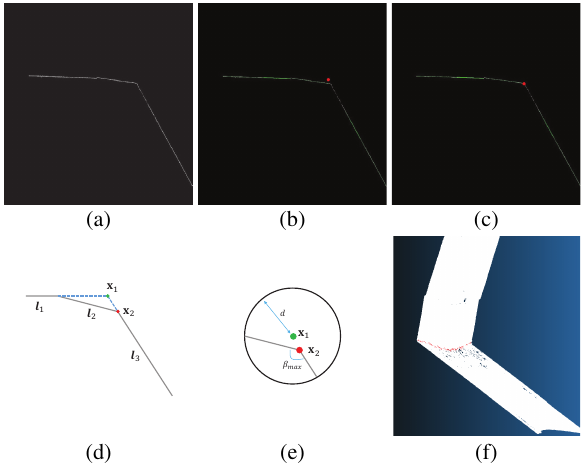
Figure 6: The illustration of extracting the vertexes on the 3D structure line: (a) the projection map of a 3D profile; (b) the intersection point marked in a red circle formed by the two green lines detected by Hough Transformation; (c) the found true vertex in the projection map; (d) the micro-structure of the bevel section which results in the intersection being x 1 instead of x 2 sometimes; (e) the demonstration to find true vertex by searching the neighboring regions with a radius d at the point with a maximum (cid:12) angle treated as the true vertex; (f) the finally extracted structure line points displayed in red on the 3D cloud points.